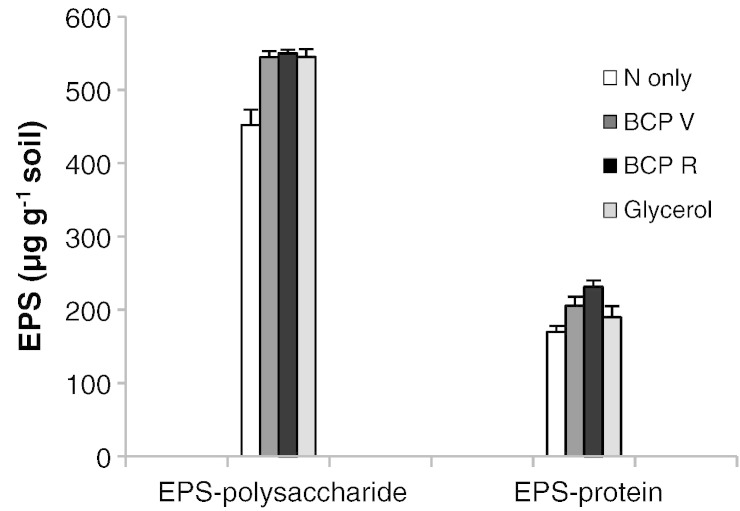
Total EPS-protein and EPS-polysaccharide determined colorimetrically. ANOVA treatment effect p = 0.025; l.s.d. EPS-protein = 36.70 μg g− 1 soil; l.s.d. EPS-polysaccharide = 41.44 μg g− 1 soil.